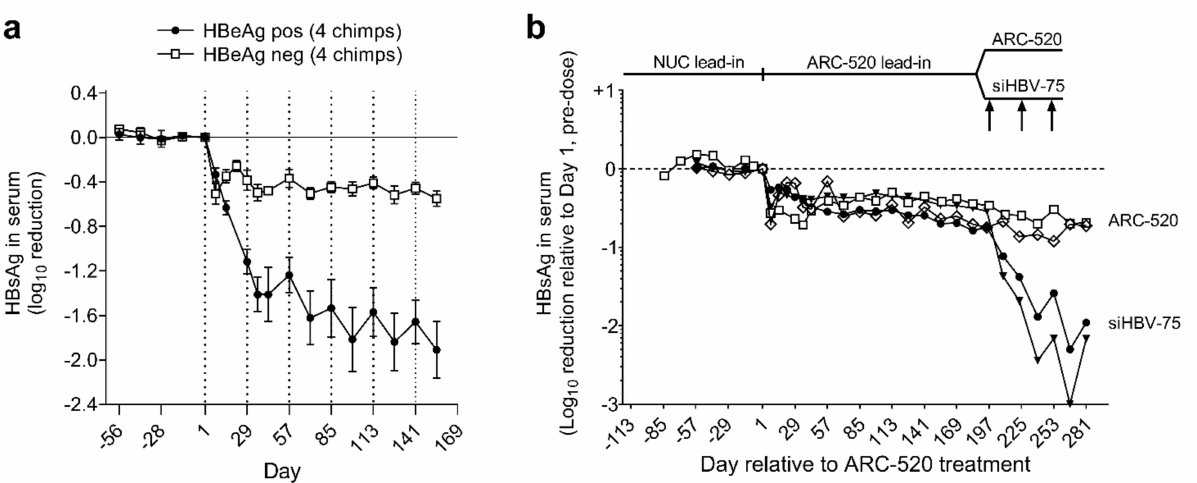
Figure 3. Response to repeat dosing of chimpanzees with HBV siRNAs. HBeAg-positive and HBeAg-negative chimpanzees began daily NUC treatment for a lead-in period of 8 to 24 weeks prior to commencing Q4W dosing with ARC-520, beginning on Day 1. HBsAg reduction is shown relative to Day 1 of ARC-520 treatment. ( a ) HBsAg reduction following 6 doses of ARC-520 in HBeAg-positive and HBeAg-negative chimpanzees. ( b ) Four HBeAg-negative chimpanzees received 7 doses of ARC-520. Then, two chimpanzees received three additional doses of ARC-520 while two animals received three doses of siHBV-75 + EX1. Reproduced from [1]. Reprinted with permission from